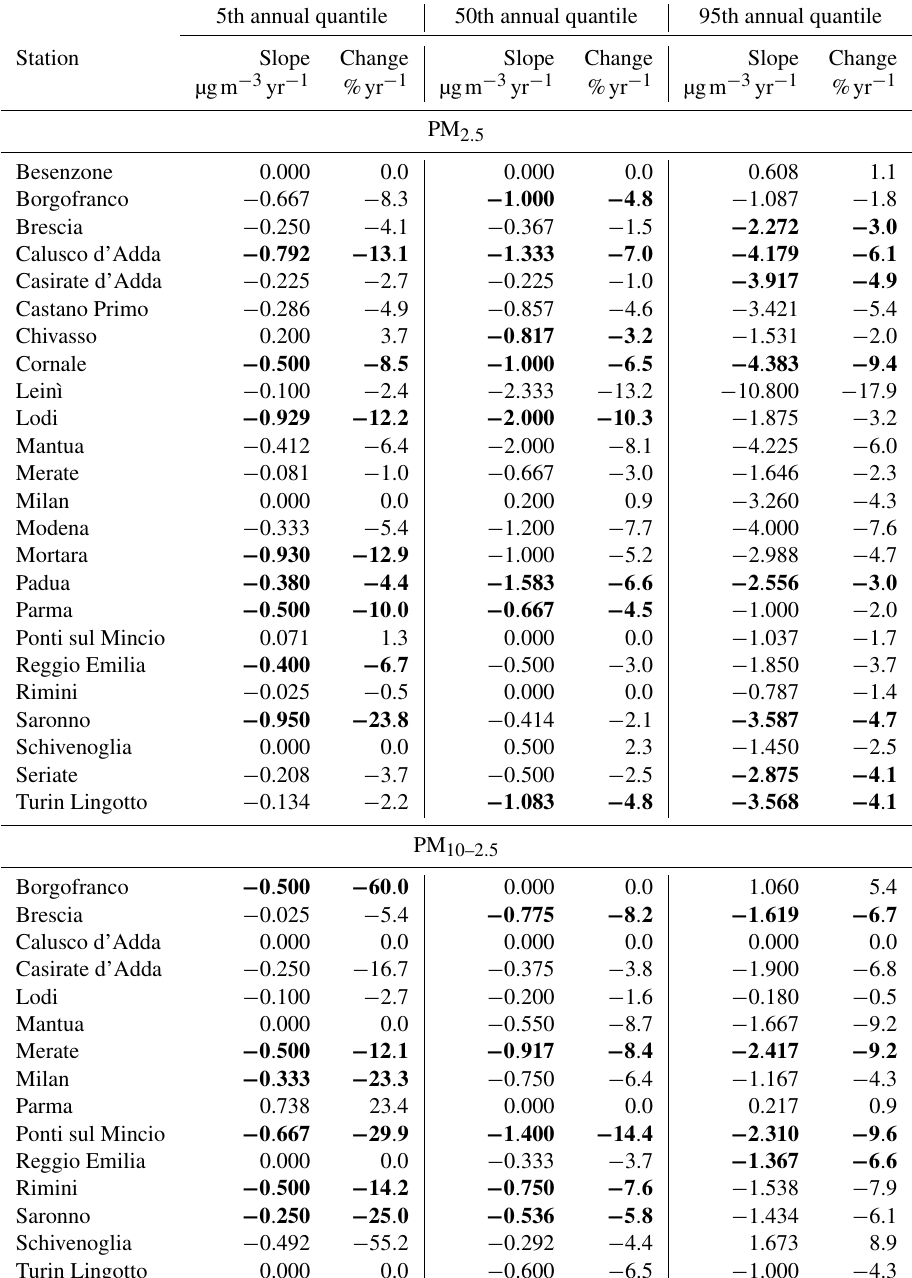
Table 3. Analysis of trend for annual quantiles of PM 2 . 5 and PM 10–2 . 5 . Slope for annual quantiles is computed by the Theil–Sen method: boldface values indicate slope significantly different from zero at the 95% confidence